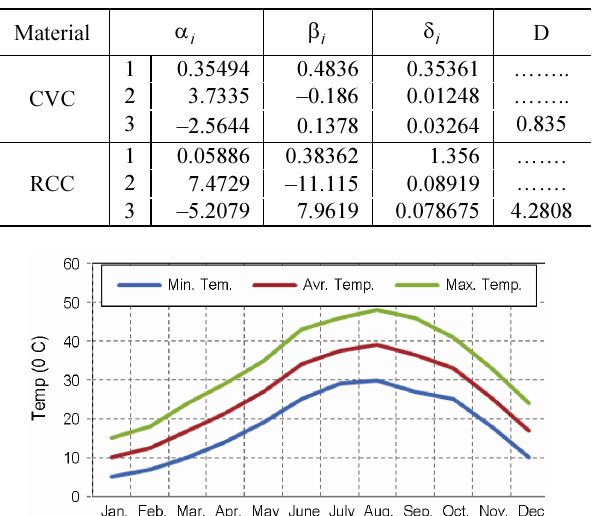
Table 3. Creep data for RCC and CMC materials (Zhang 1995)